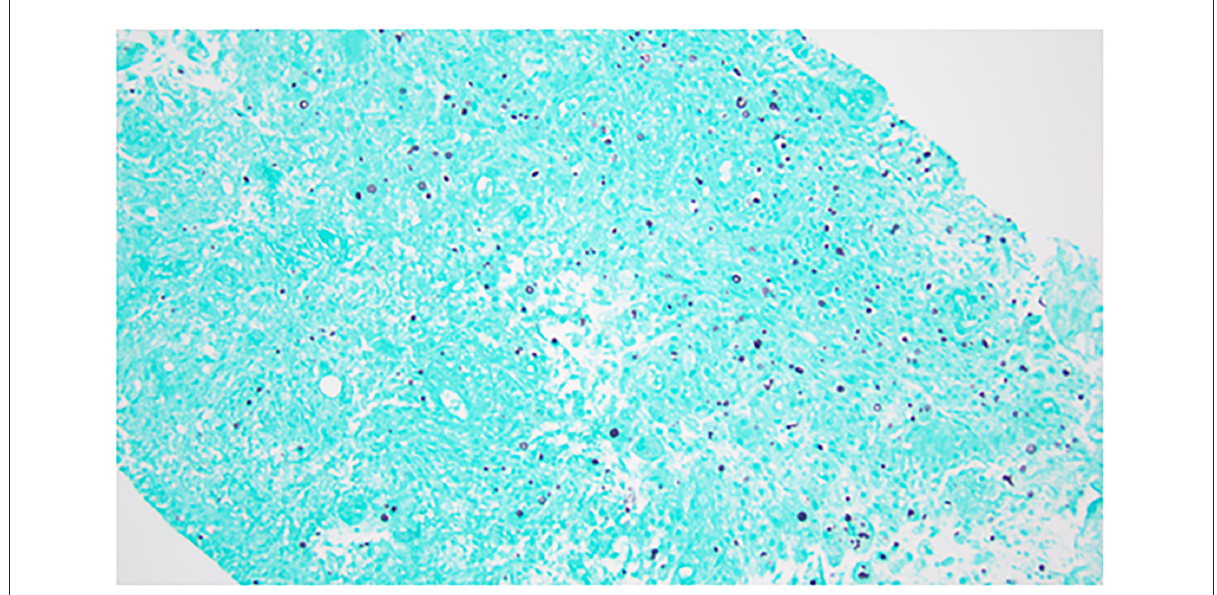
FIGURE3 Grocott’s Methenamine Silver (GMS) stain of aspirate showing yeast forms. Objective: 200 × .